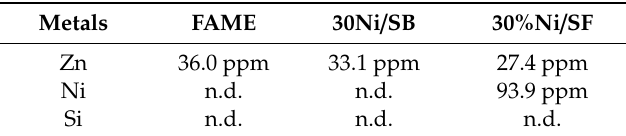
Table 3. Elemental analysis of FAME and H-FMAME obtained the 30 wt% Ni / SB and 30 wt% Ni / SF